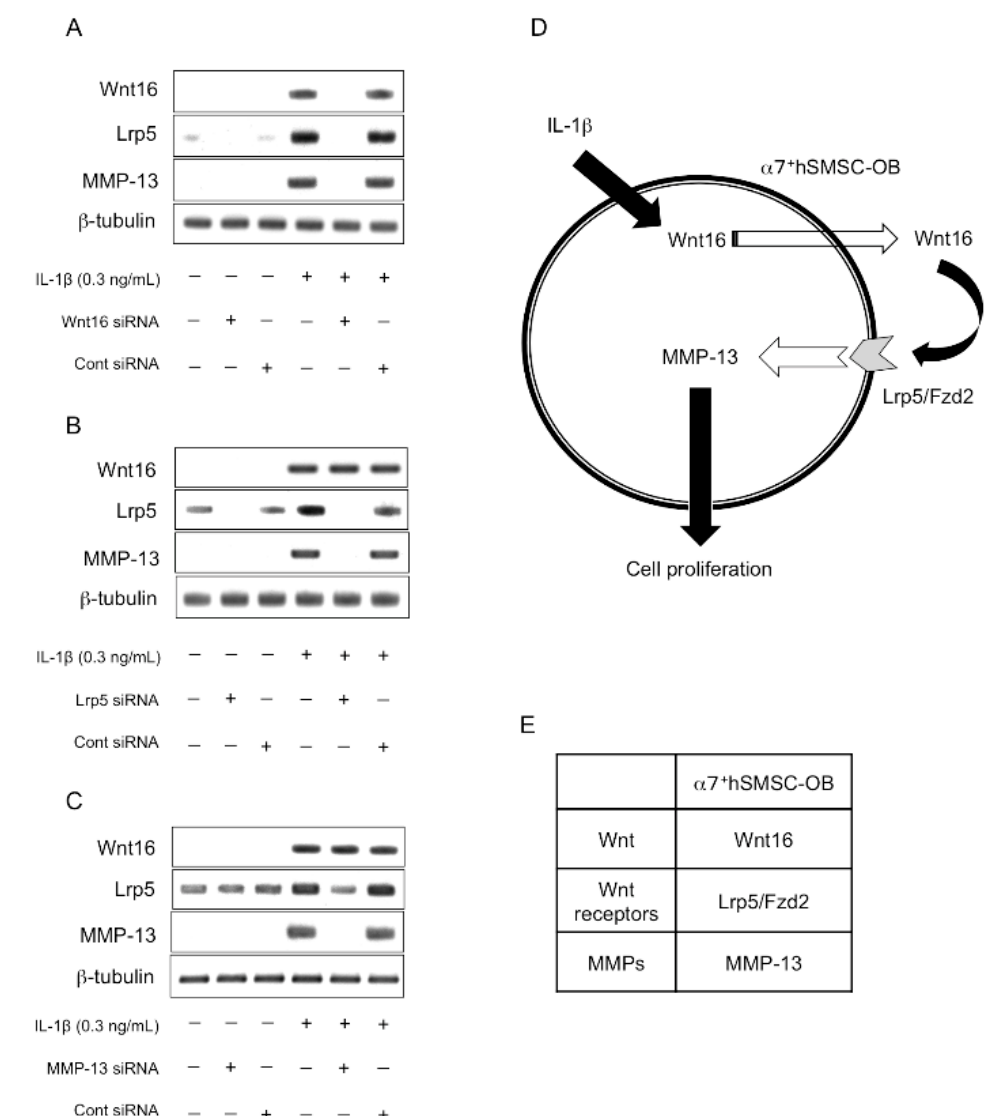
Figure 6. Determination of the signaling sequence using specific siRNAs. Cells were incubated for 24 h in serum-free medium containing IL-1 β (0.3 ng/mL) and ( A ) Wnt16; ( B ) Lrp5; or ( C ) MMP-13 siRNAs. Protein expression of Wnt16, Lrp5, and MMP-13 was determined by Western blotting and compared with the expression of a housekeeping gene ( β -tubulin). Images are representative of at least three independent experiments; ( D ) Schematic illustrating the putative signaling pathway by which IL-1 β stimulates MMP-13 activity to induce the proliferation of α 7 + hSMSC-OB cells; ( E ) the different signaling cascades in IL-1 β -induced proliferation of α 7 + hSMSC-OB